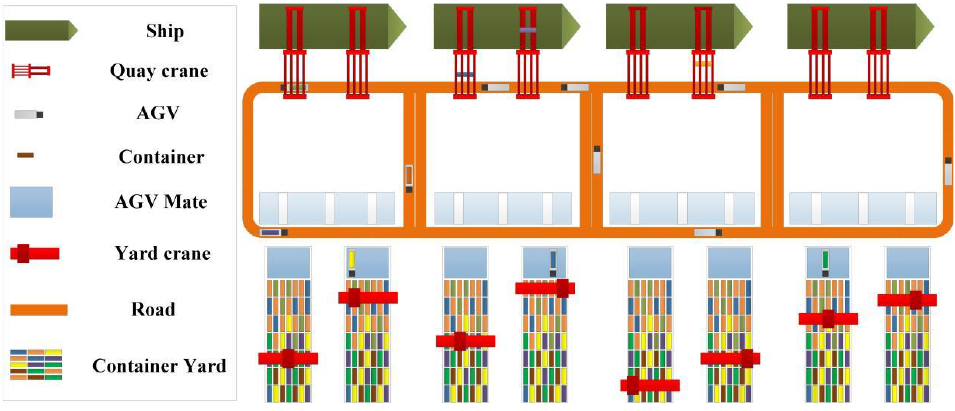
Figure 1. Automated terminal seaside scheduling scenario.